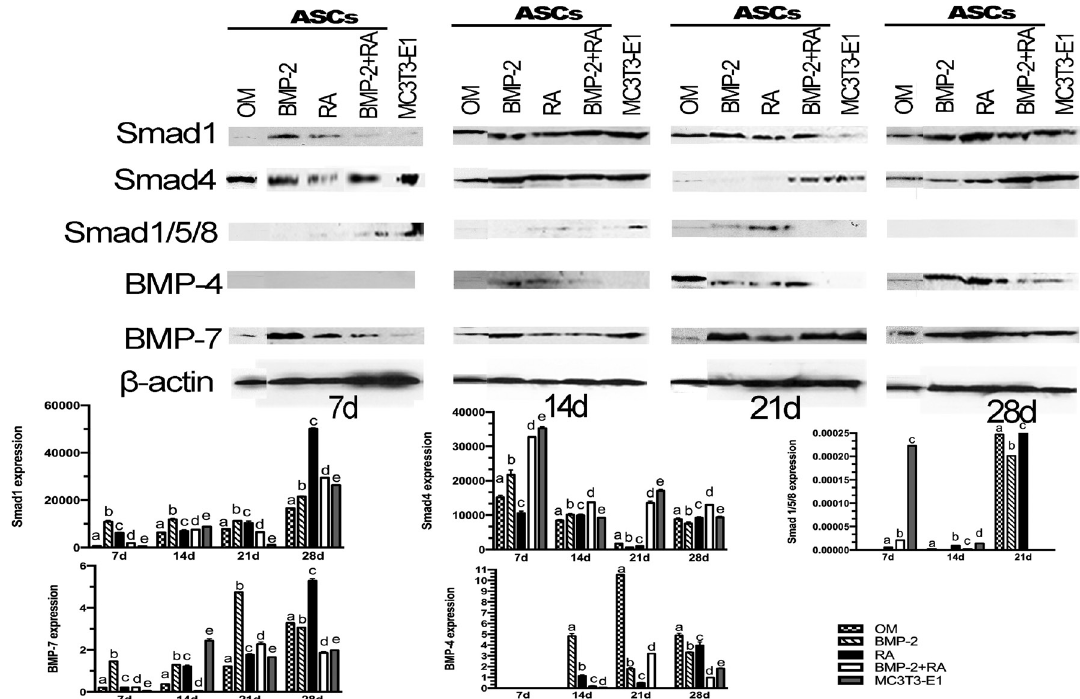
Figure 3- Expression of osteoblast-related proteins. Proteins expressions evaluated by western blotting at days 7, 14, 21, and 28 of ASCs treated according to the groups: OM (osteogenic medium); BMP-2 (OM and BMP-2); RA (OM and retinoic acid, RA); BMP-2+RA (OM, BMP-2, and RA). MC3T3-E1 was used as positive control. Bands are representative of three independent experiments. Band intensities were quantified. Different letters represent statistically significant differences ( r <0.05) (ANOVA/Tukey) among treatments at each